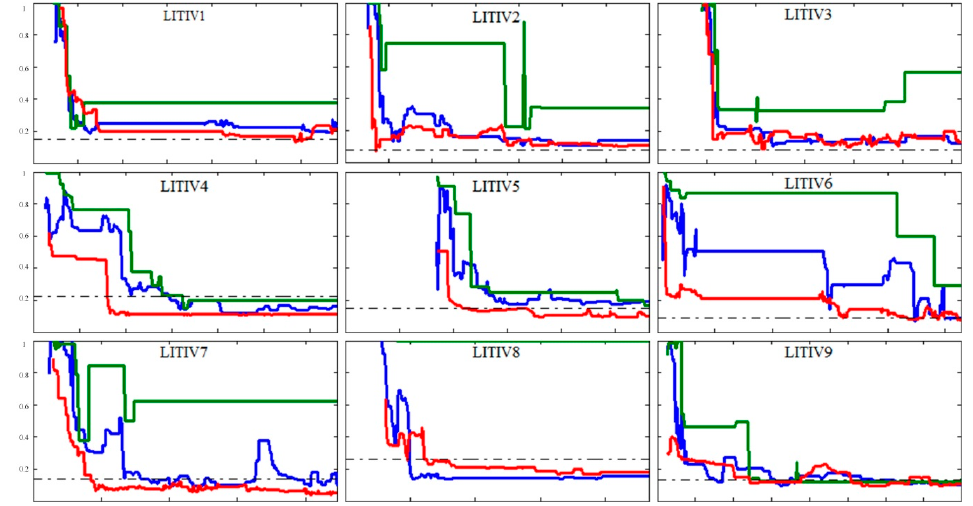
Figure 8. Polygon overlap errors obtained using our framework (solid red), the method of [13] (solid blue), the method of [14] (solid green), and the ground-truth homography (dot-dashed gray) for the full lengths of all sequence pairs of the LITIV dataset.